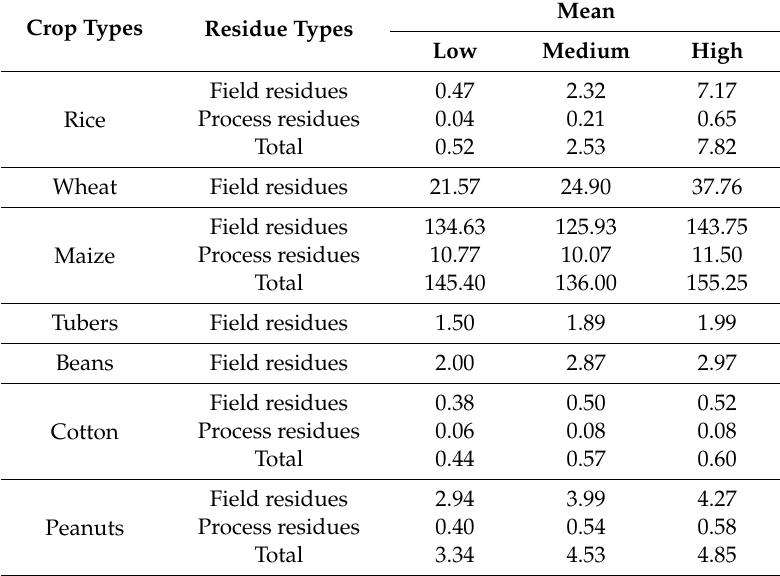
Table 4. The theoretical maximum potential availability (10 4 t) of crop